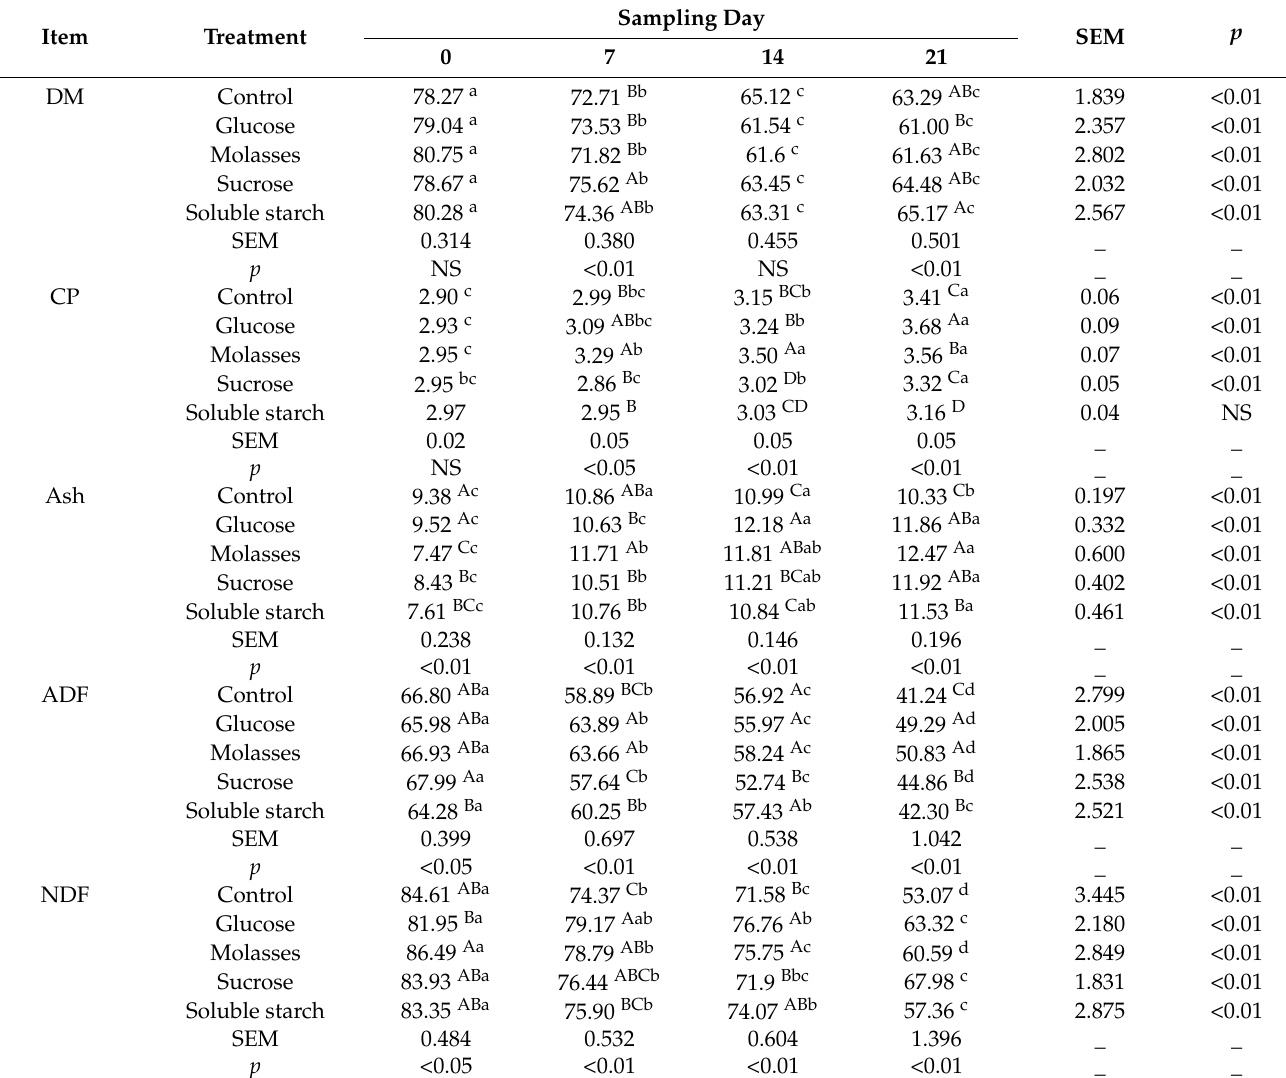
Table 2. Chemical composition of rice straw fermented by white rot fungi with the addition of different carbon sources (g/kg DM) after 0, 7, 14, and 21